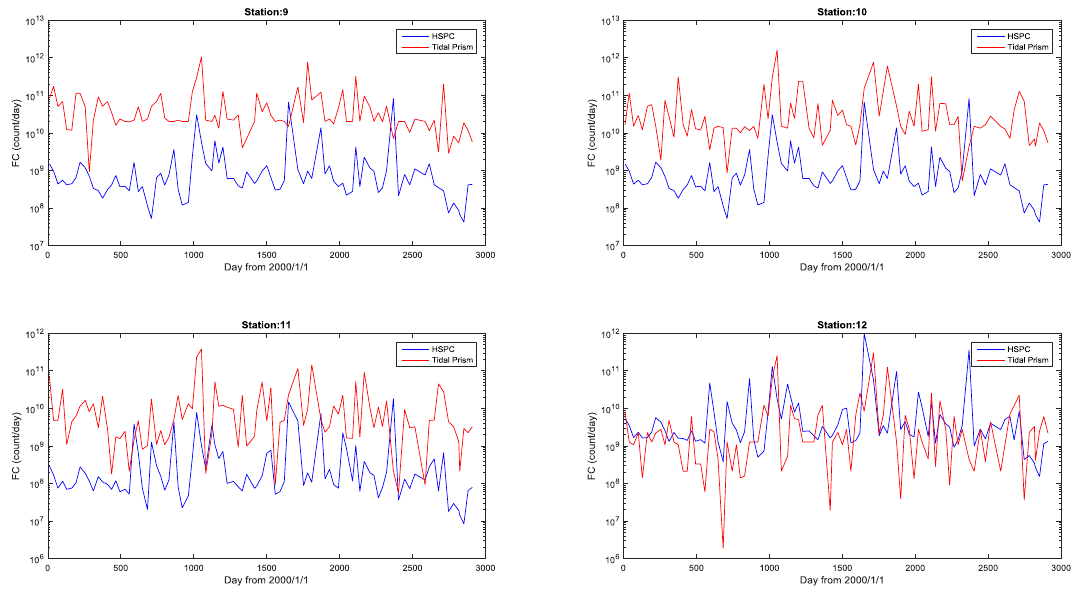
Figure 8. Comparison of bacterial loading simulation between the watershed model and the inverse tidal prism model.